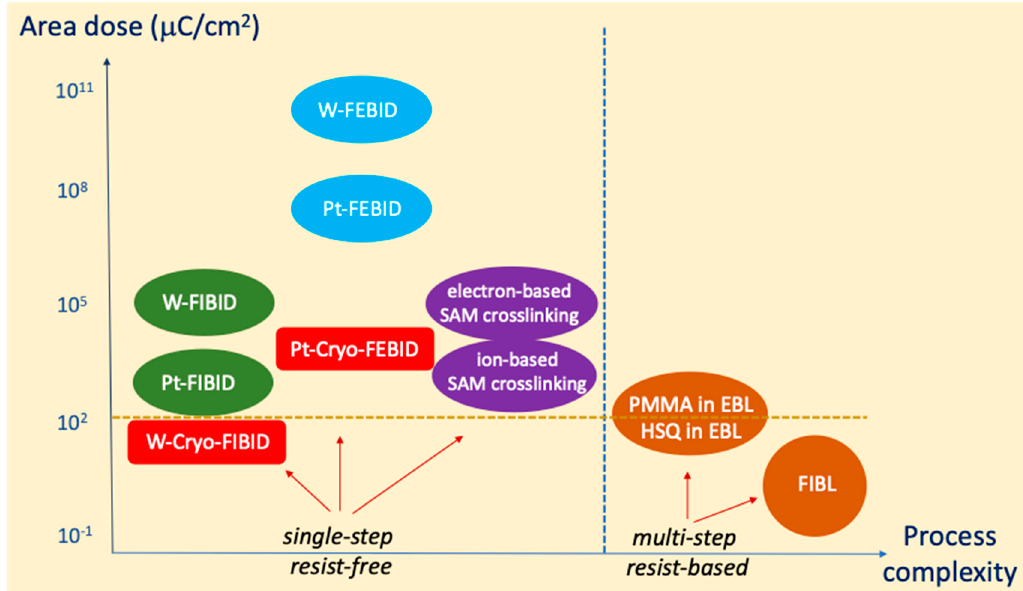
Figure 7. Comparison of charge-particle-based lithography techniques in terms of the required charge dose per area and the process complexity. The single-step or multi-step character of the technique is considered a means to classify it as a process with less or more complexity, respectively. Cryo-FIBID requires the lowest charge dose amongst the single-step techniques.